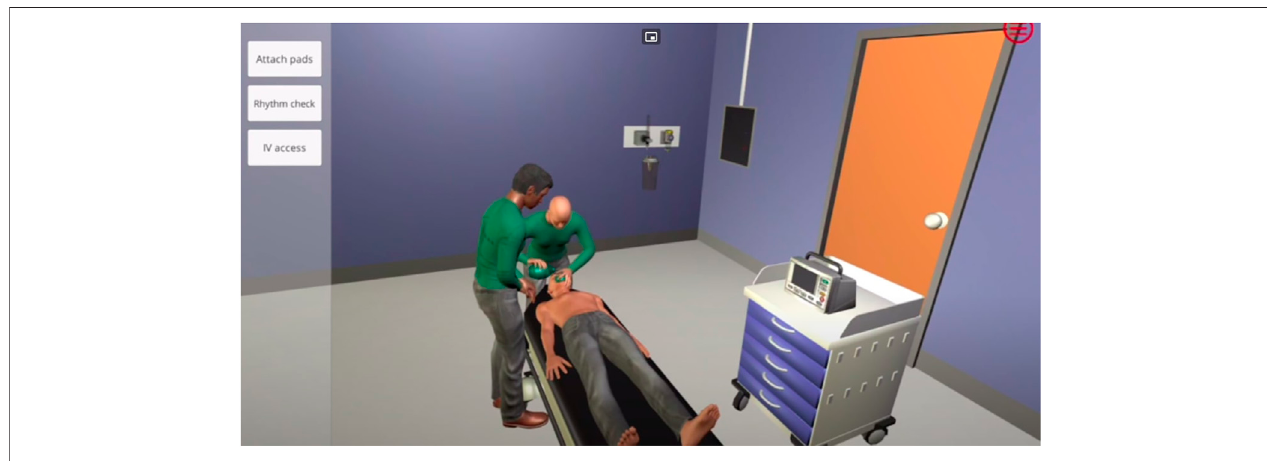
FIGURE 5 | Virtu-ALS.